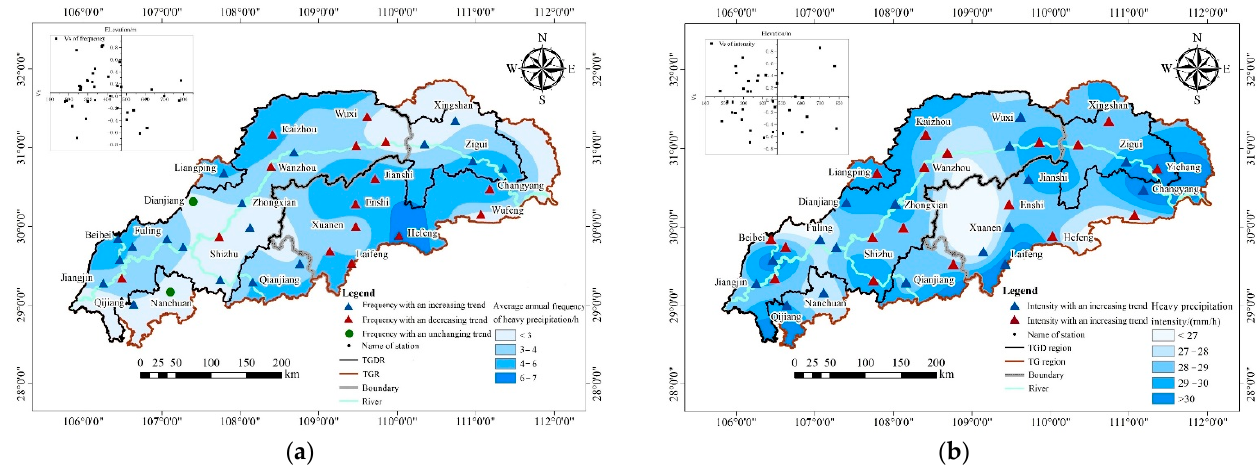
Figure 8. Spatial distribution of ( a ) frequency of heavy precipitation and ( b ) average intensity of heavy precipitation in the TGRR from 1999 to 2020.